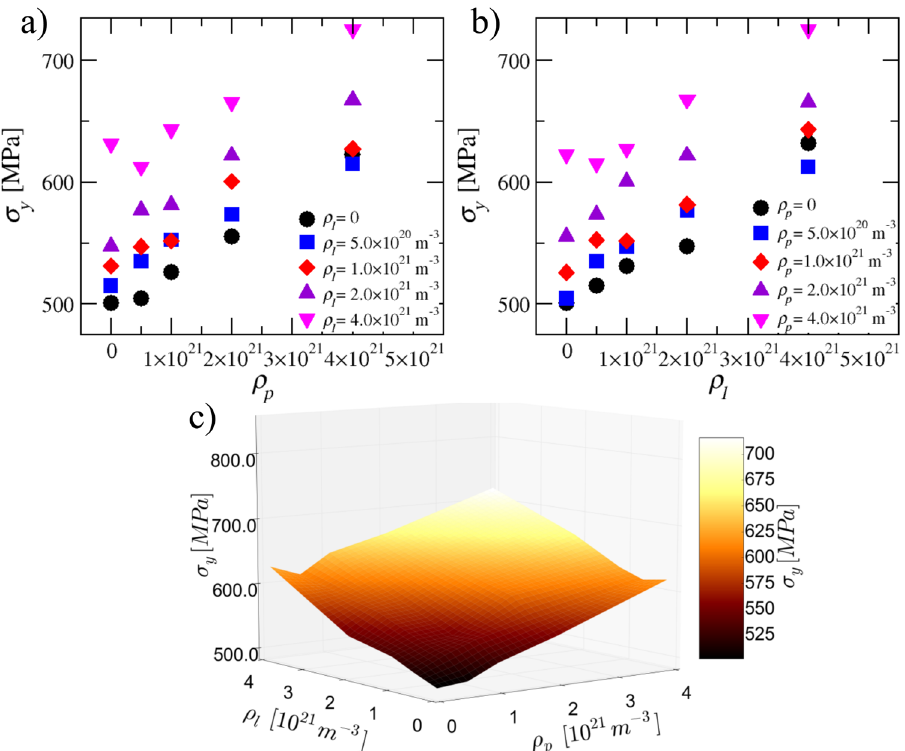
Figure 8. ( a ) Yield stress as a function of precipitate density for different loop densities. ( b ) Yield stress as a function of loop density for different precipitate densities. ( c ) A 3D surface plot of yield stress as a function of both loop and precipitate densities. Linear interpolation was used between the datapoints. Precipitate size parameter is R p = 5 nm and the loop radius is r l = 5